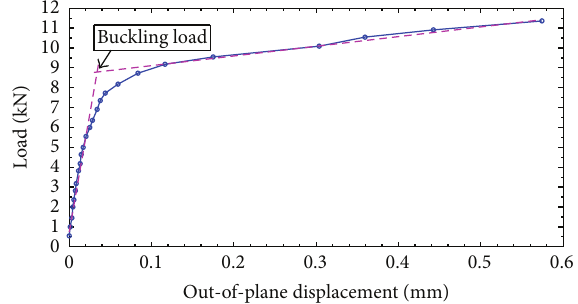
Figure 8: Relationship between the maximum out-of-plane dis- placement and compressive